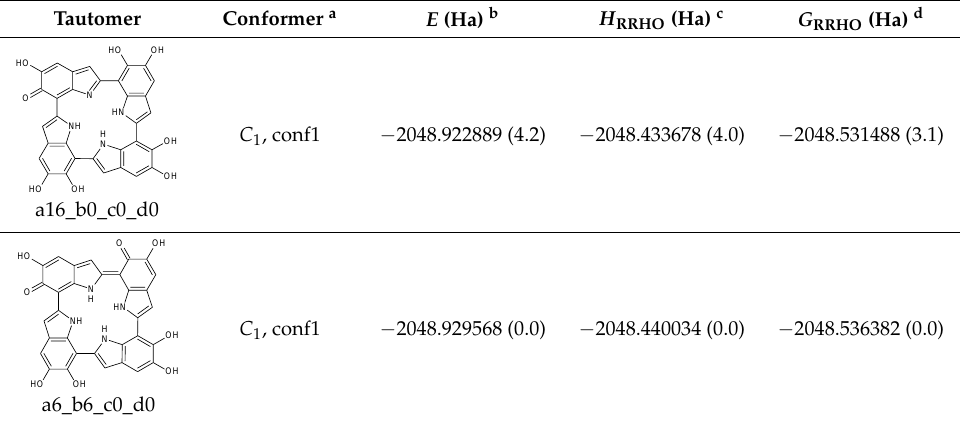
Table 7. KP-2e, neutral form in vacuo.